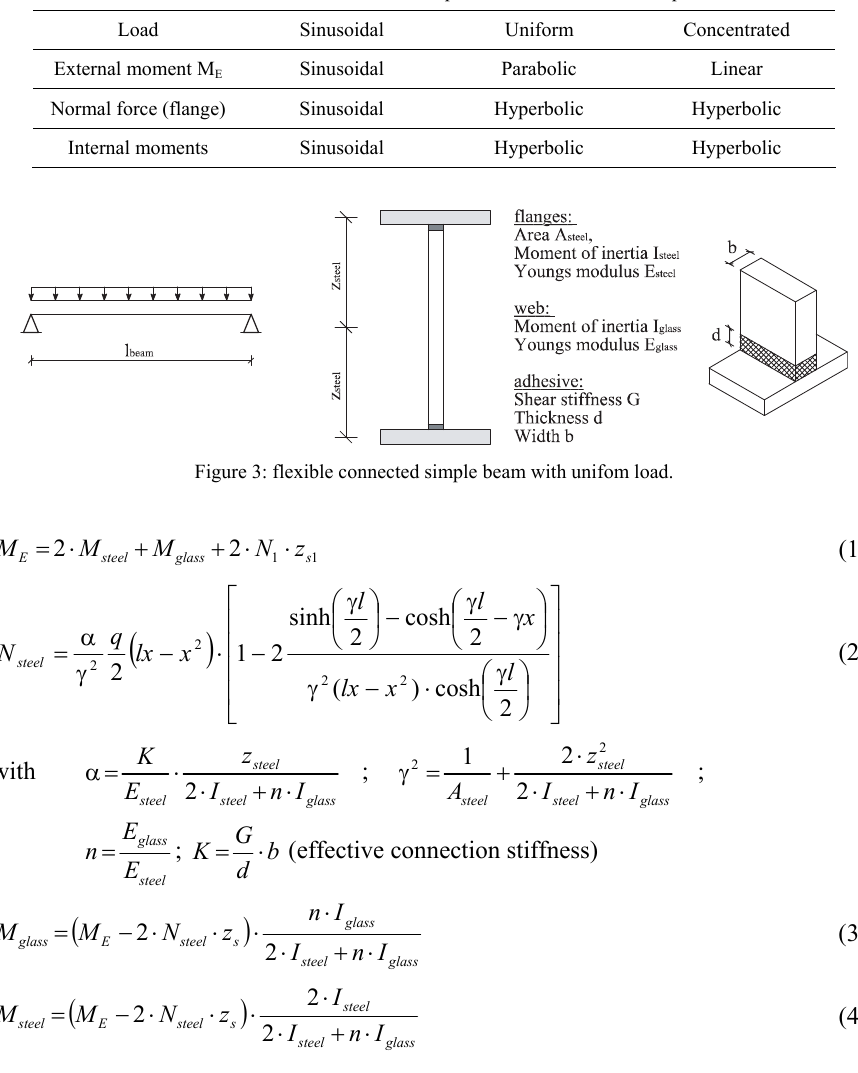
Table 1: Distribution of internal forces of simple beams with flexible composed sections